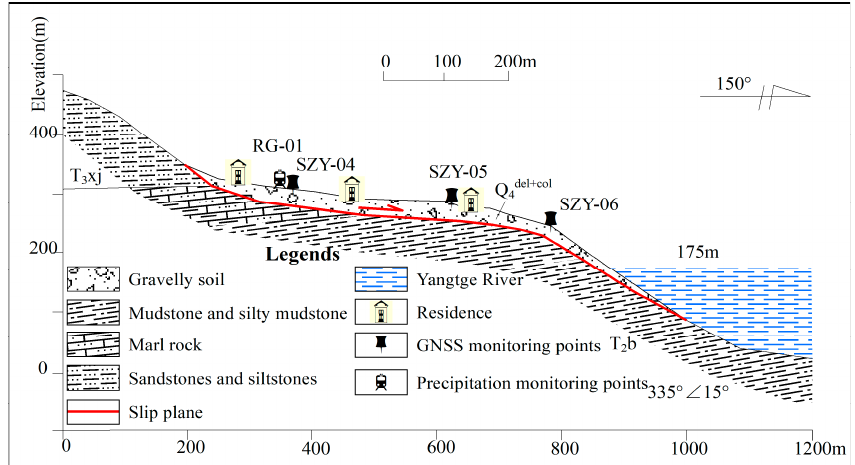
Figure 3. The engineering geological profile of the Shuizhuyuan landslide.